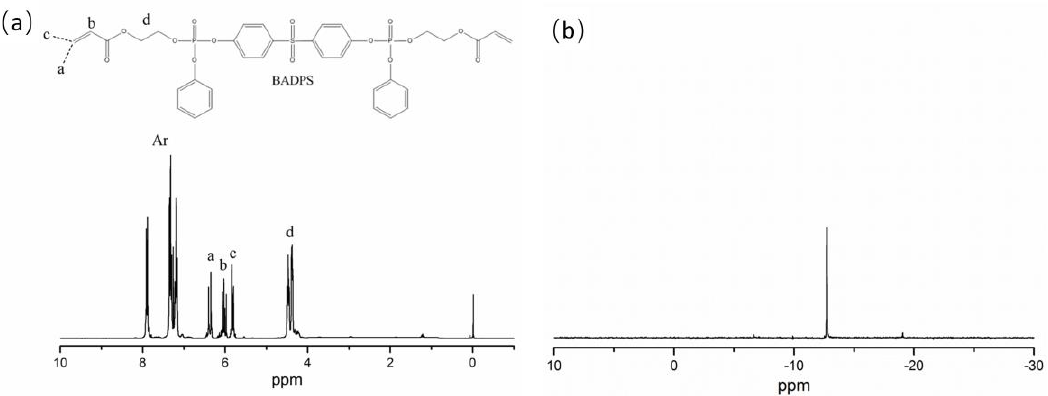
Figure 1. ( a ) 1 H NMR and ( b ) 31 P NMR spectra of